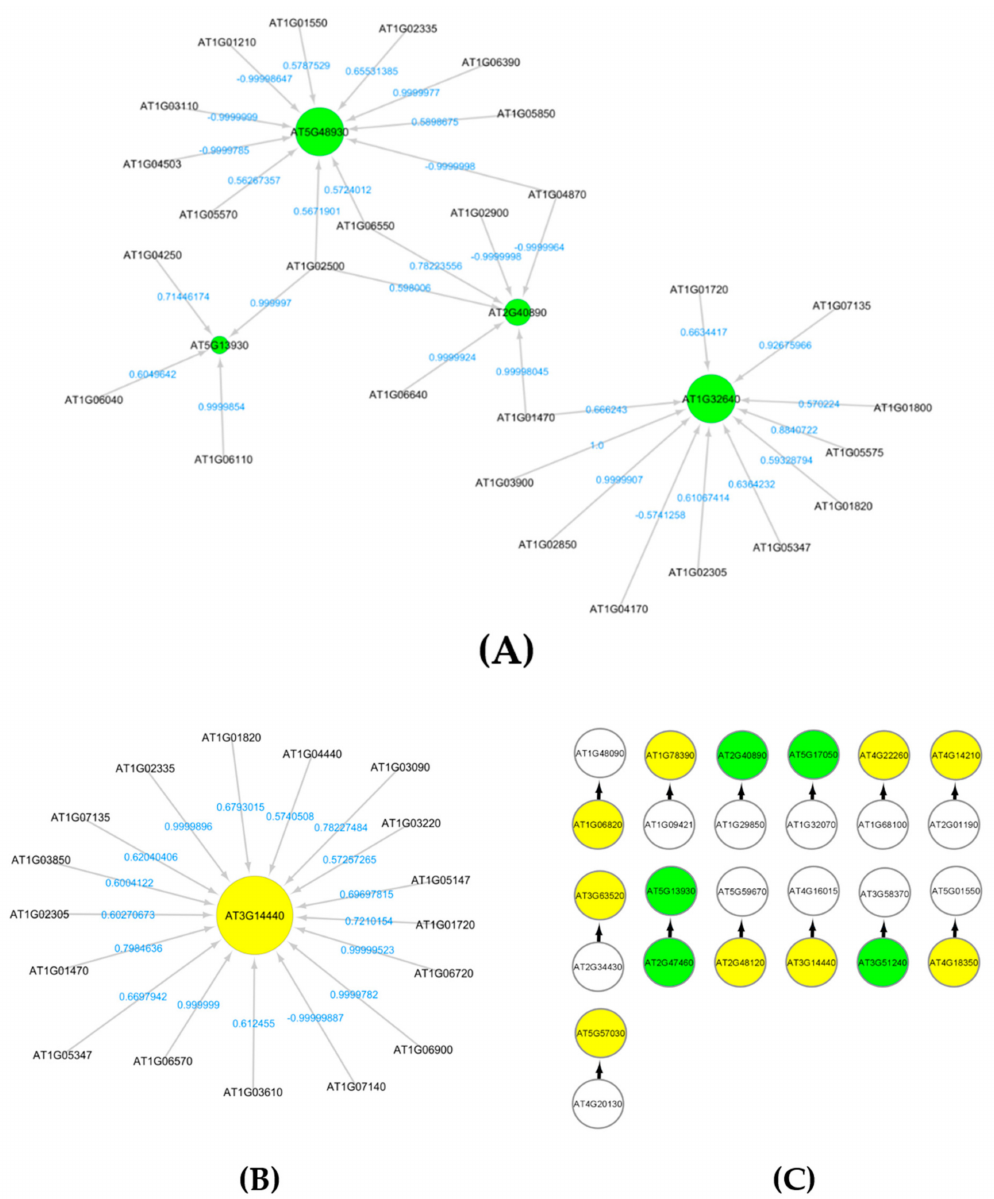
Figure 4. ( A ) Subnetwork for flavonoids biosynthesis process under light environment in space Figure 4. (GLDS-120) dataset. ( B ) Subnetwork showing carotenoid AT3G14440 interactions. This is a key enzyme in the biosynthesis of abscisic acid. It is regulated in response to drought and salinity and expressed in roots, flowers and seeds. ( C ) Markov blanket subnetwork showing causal relations of flavonoids (green) and carotenoids